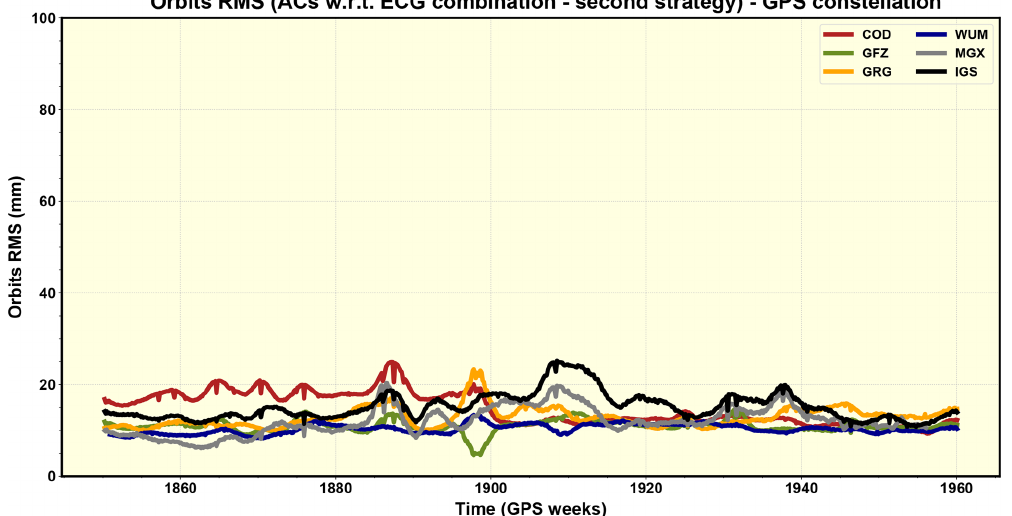
Figure 5. RMS with respect to the individual ACs’ MGEX submission GPS orbits and the GPS ECG combination results computed by the Helmert-based strategy .